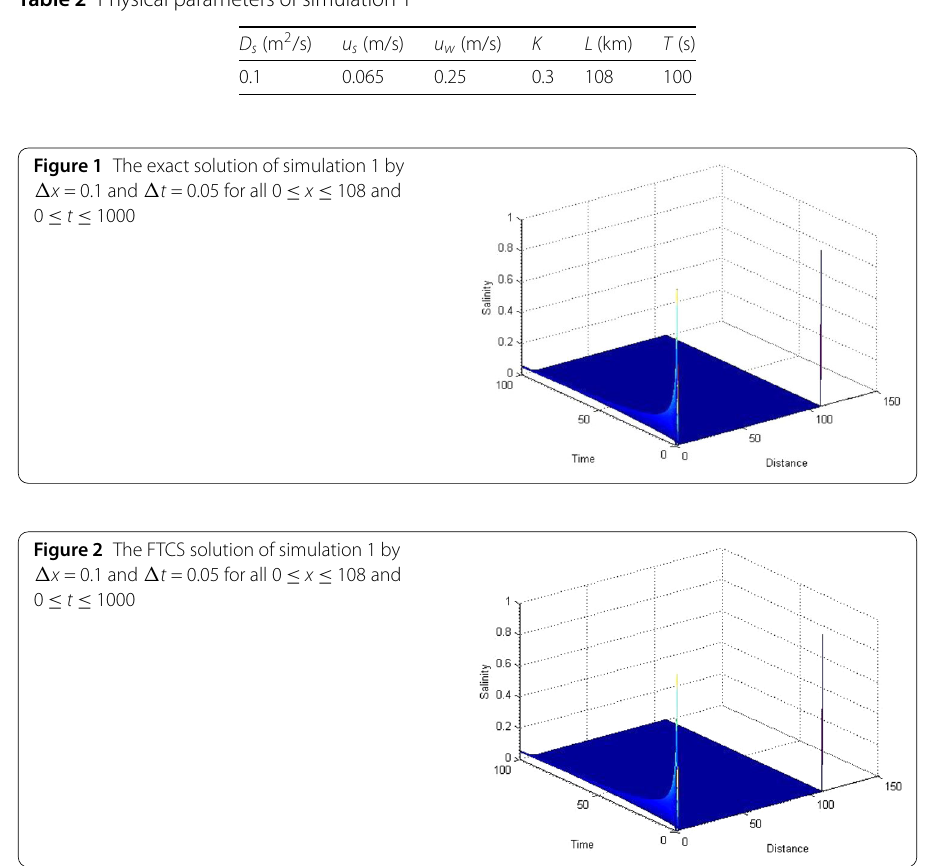
Table 2 Physical parameters of simulation 1